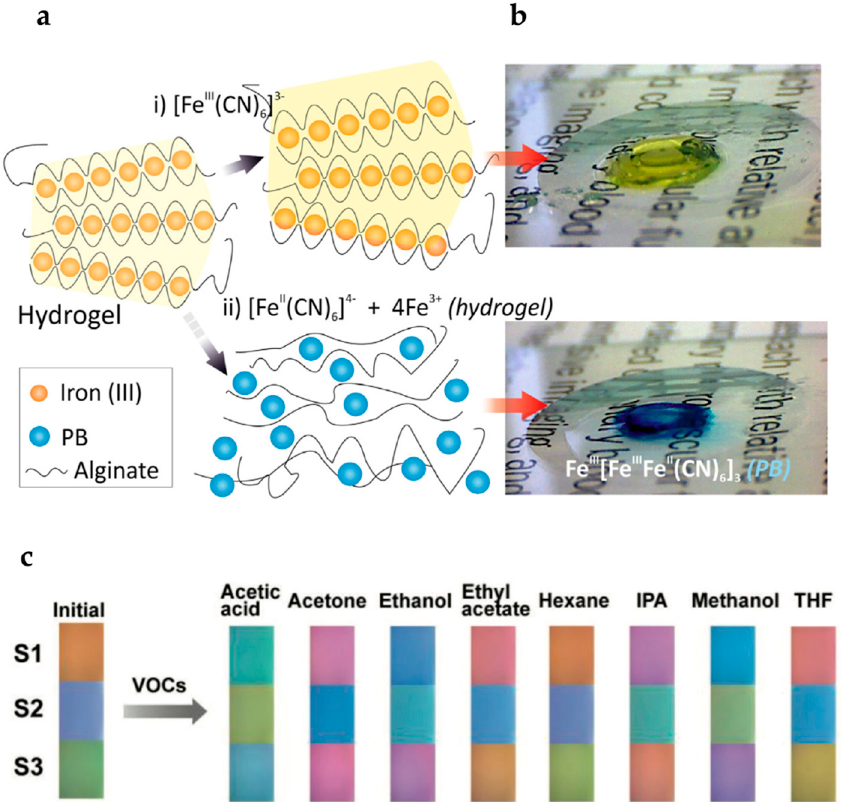
Figure 4. Analyte-responsive hydrogels: ( a ) schematic representation and ( b ) photographs of a bacterial metabolic activity-response hydrogel, based on an electrochromic iron(III)-complexed alginate system with antibiotic-susceptibility. In this biomaterial, the reduction of ferricyanide to ferrocyanide by the bacteria will lead to the formation of Prussian blue molecules, macroscopically observed by the strong chromatic change of the hydrogel from yellow to blue [58] (Reprinted from ref. [58]. Copyright 2018 Elsevier); ( c ) sensor array composed of poly(2-hydroxyethyl methacrylate- co -AAc) deposit on top of a reflective substrate with tree different thickness (234, 290 nm and 362 nm for S1, S2 and S3, respectively). When the system is expose to different volatile organic compounds one can observe a change in coloration due to the diverse swelling behavior observed for each VOC. For each VOC the system response gives rise to a specific pattern, even for similar analytes such as alcohols (methanol, ethanol, and IPA) (Reproduced from ref. [59]. Copyright 2017 John Wiley and